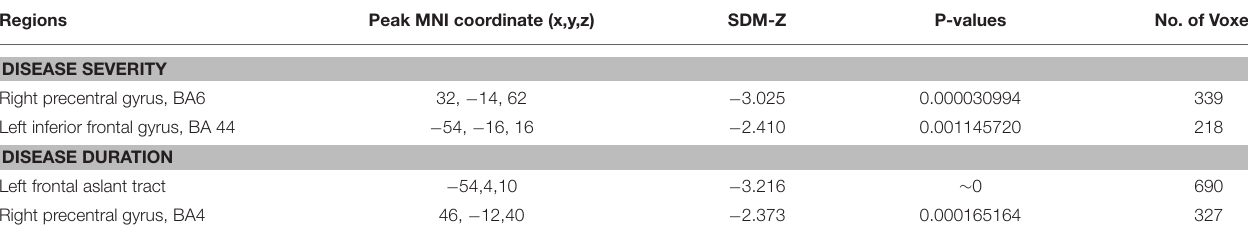
TABLE 4 | Meta-regression analyses of disease severity and duration on GM abnormalities in patients with ALS.